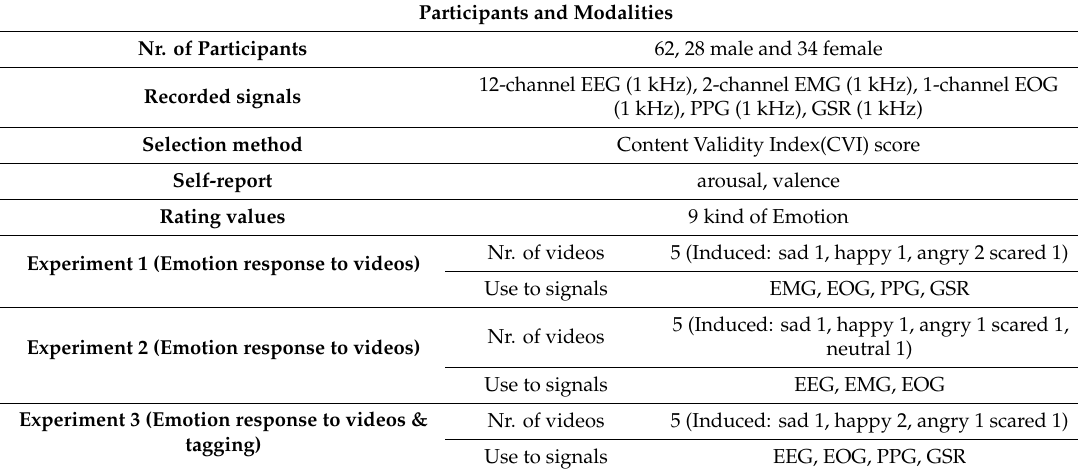
Table 4. Summary of MERTI-Apps dataset.